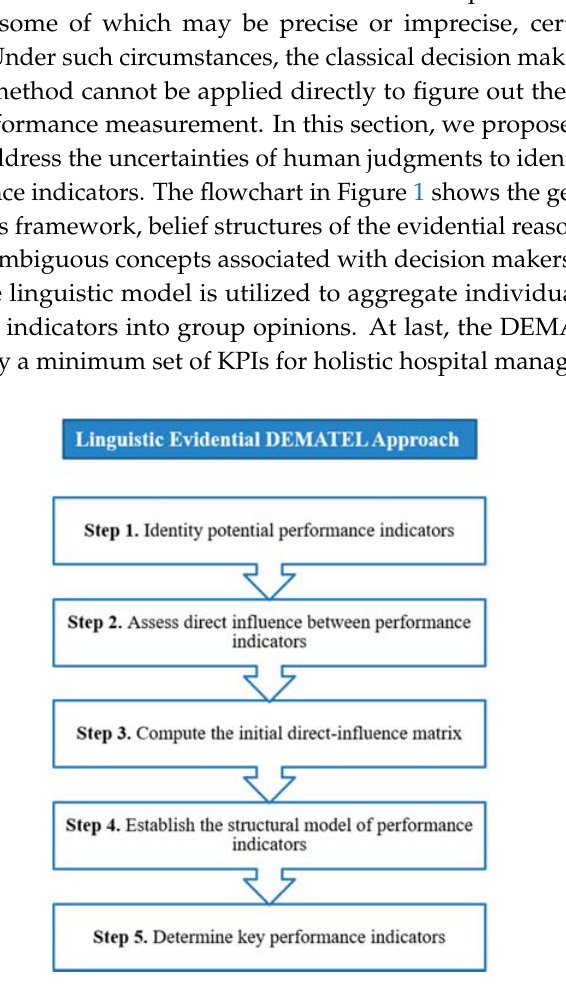
Figure 1. Framework of the linguistic evidential DEMATEL approach.